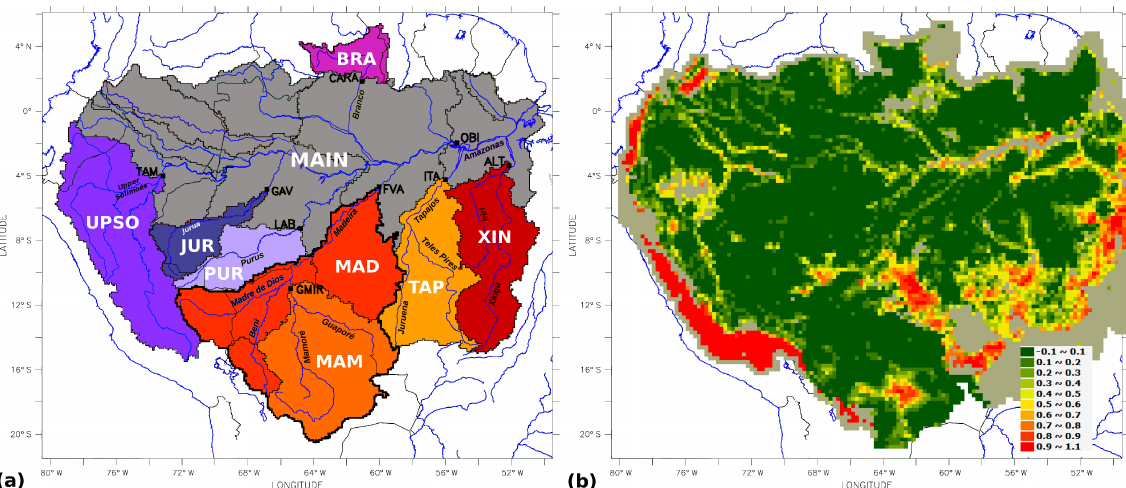
Figure 1. Panel (a) indicates Amazon catchments (names in white; the abbreviations are indicated in Table S1) and the main rivers (adapted from Guimberteau et al., 2012), with localization of the main SO HYBAM gauging stations (the abbreviations are indicated in Table S1). The bold black line delineates the Madeira catchment. Colour is used to distinguish the southern (red), western (purple) and northern catchments (pink). Panel (b) indicates the percentage of deforestation in each 25 × 25km 2 in 2005 (observed data; Aguiar et al.,